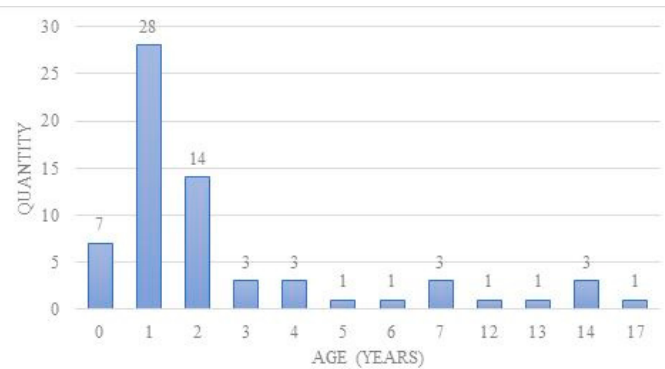
Figure 1. Age of patients suspected of foreign body aspiration.